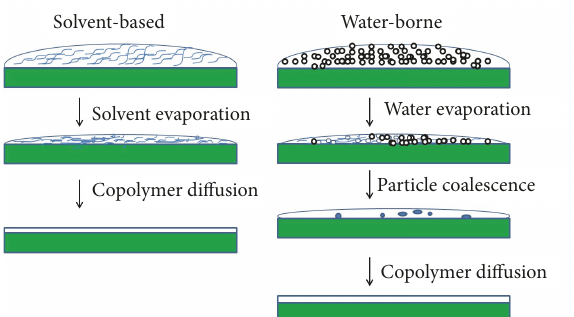
Figure 4: The film formation processes at room temperature for the solvent-based and the water-borne copolymers with Tg of approximately